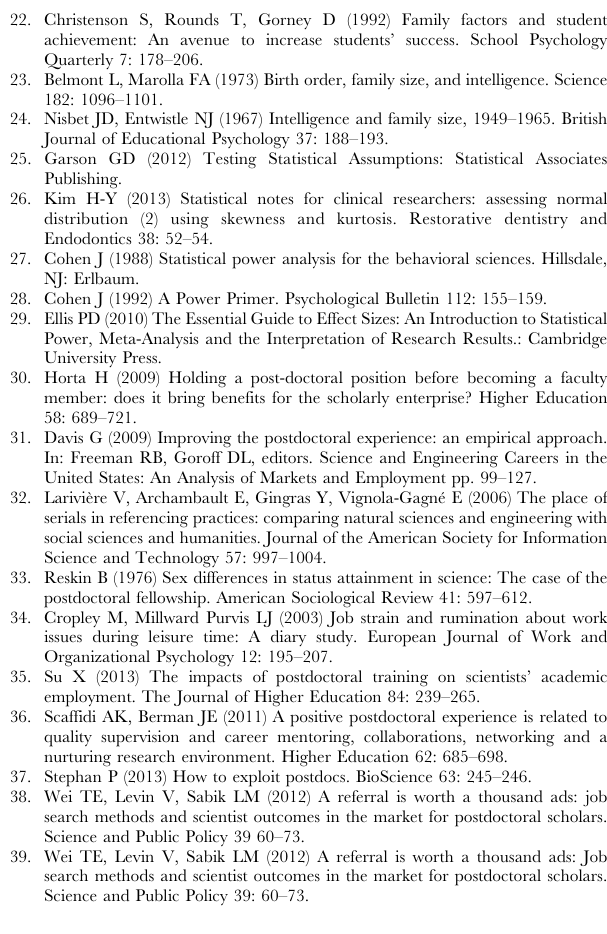
Table S1 Universities and specialized, independent research centres represented in this study. The number of participants from each institution is given in the parenthesis. Table S2 Some of the questions used in this study. The questions are grouped by core topic. Questions related to the different questionnaires ( N = 5) were removed. PDR refers to postdoctoral researcher (also referred to as